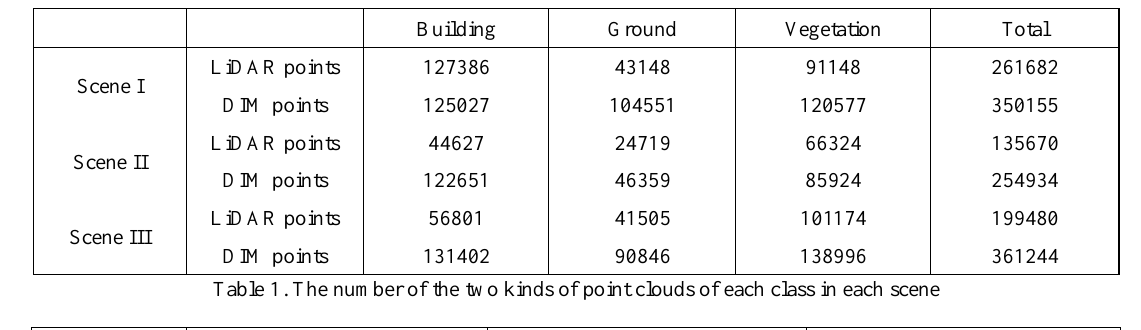
Figure 3. Test data (blue is the building point, green is the ground point, and red is the vegetation point) Building